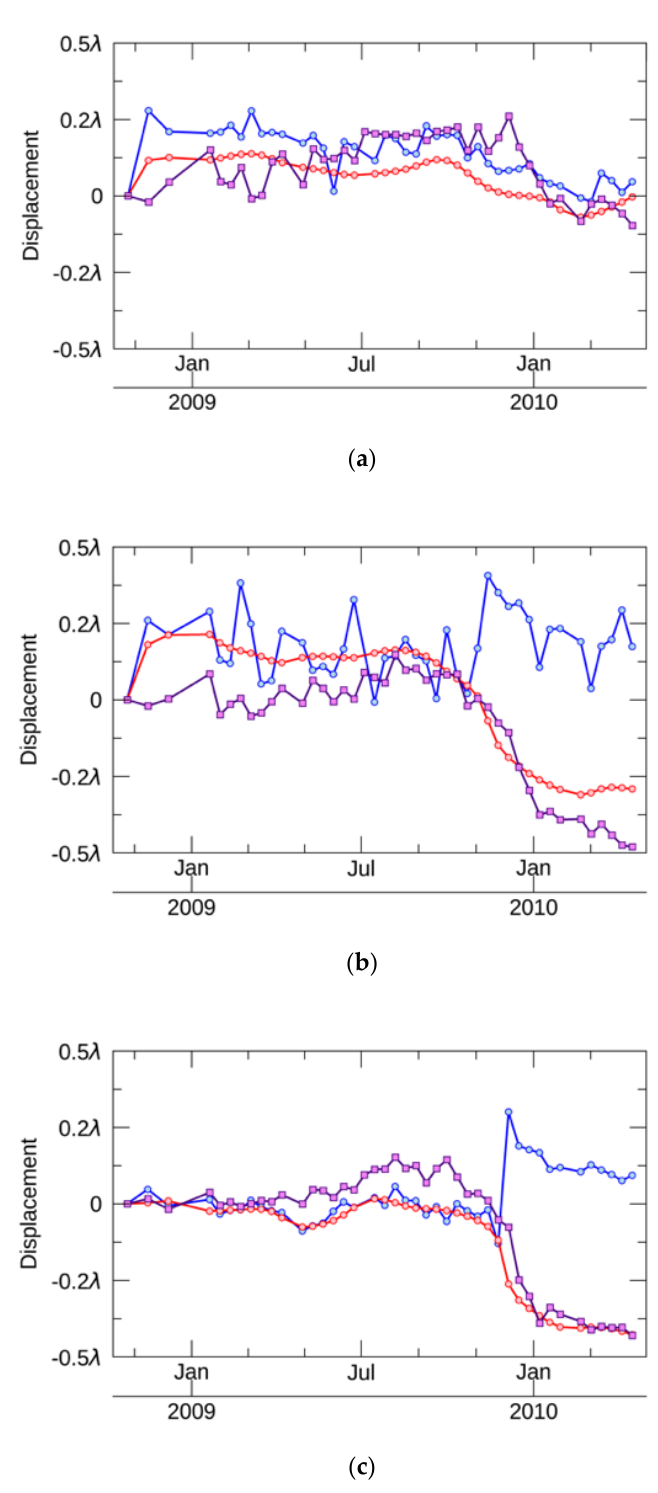
Figure 11. ( a )–( c ) The time evolutions at Pt1, Pt2, and Pt3. In the time plots, the red, blue, and purple lines show NN-PSI, ConvPSI, and Small BAseline Subset (SBAS) displacements, respectively.